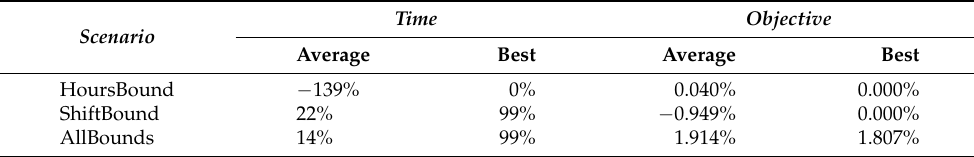
Table 10. Improvements of bound schemes over the NoBounds